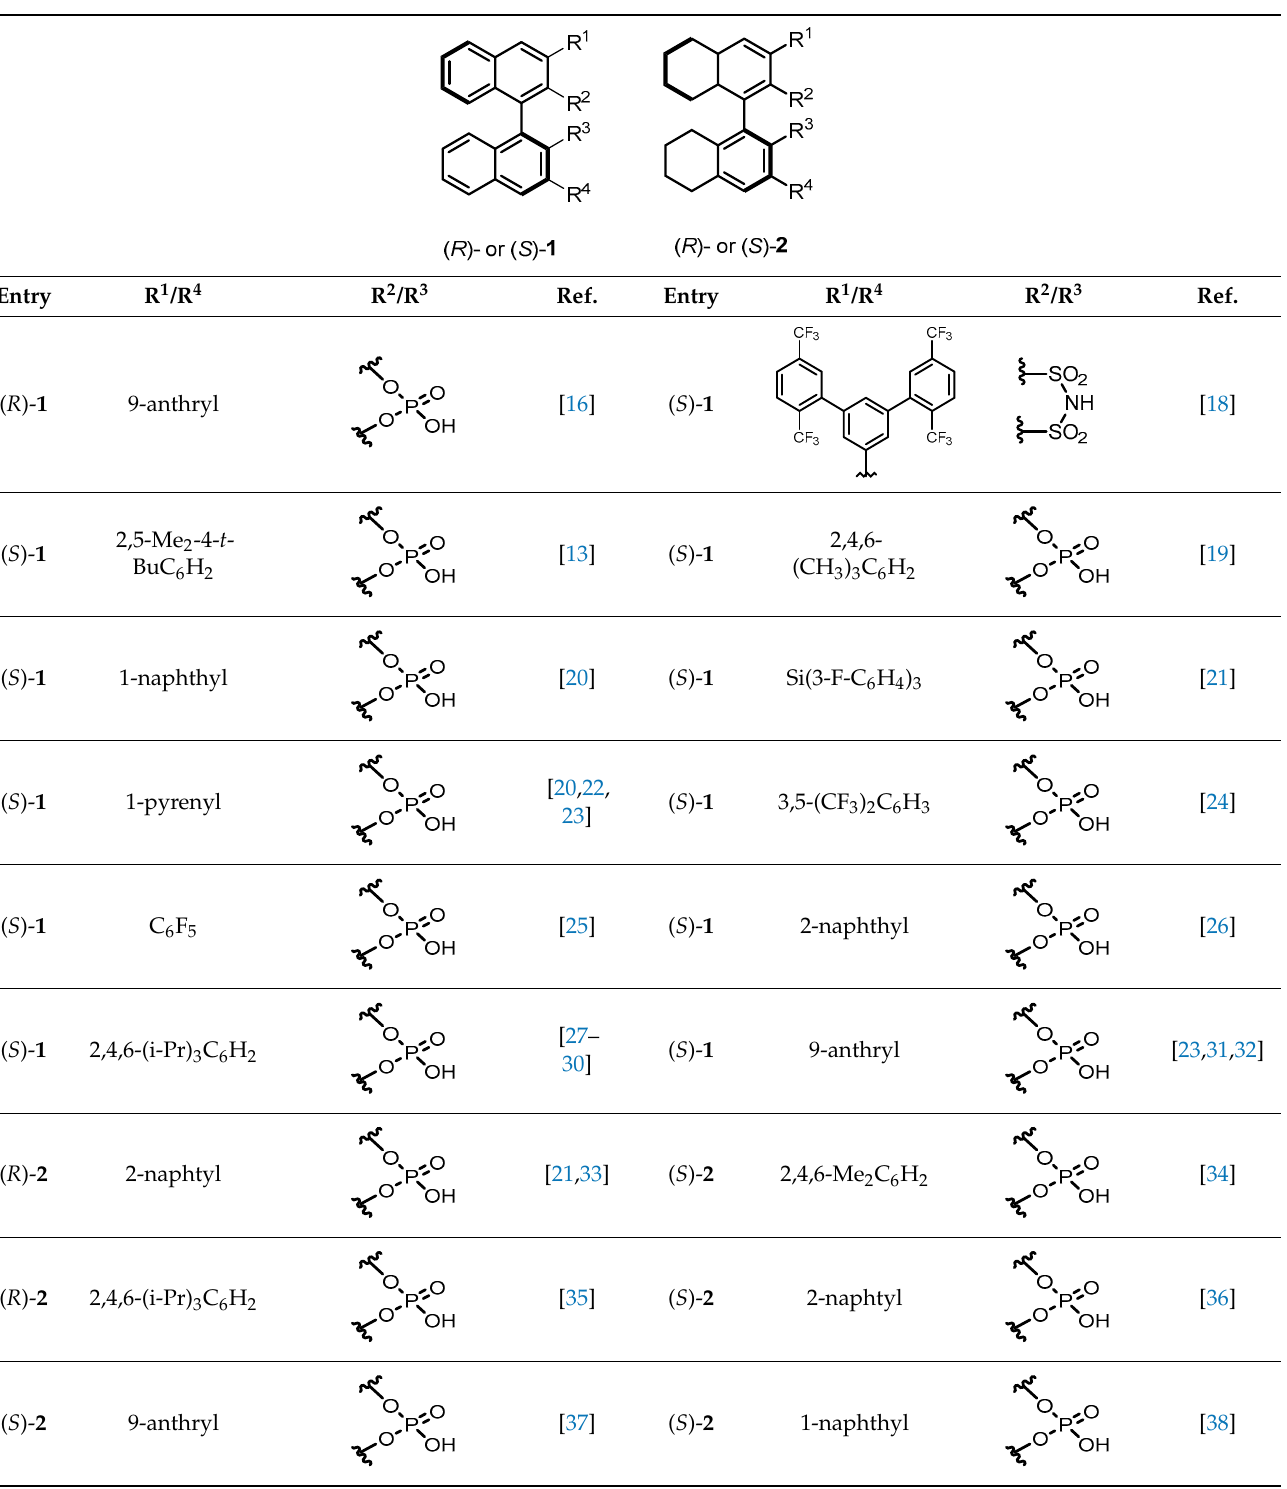
Figure 2. Examples of biologically active compounds with axial chirality.